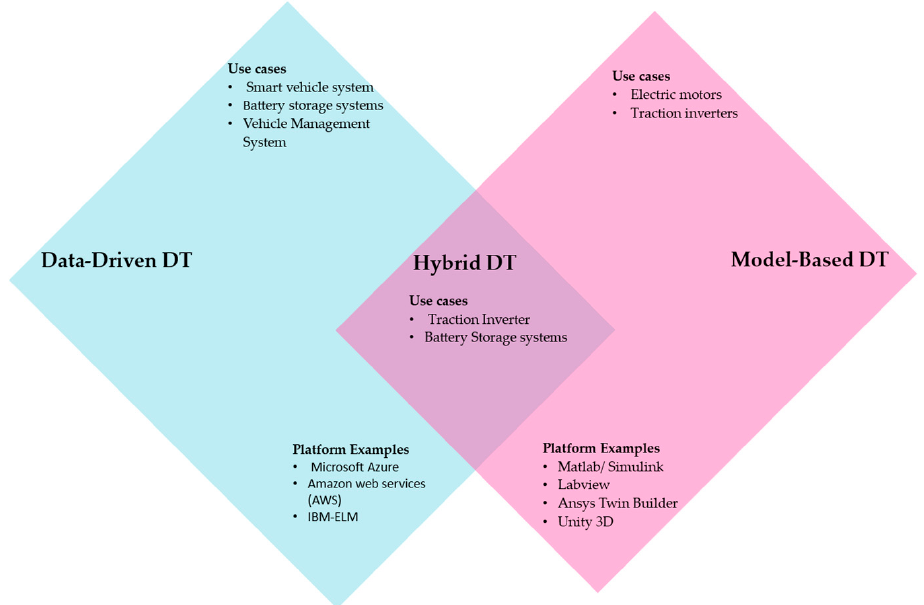
Figure 4. DT architectures for different EV systems.